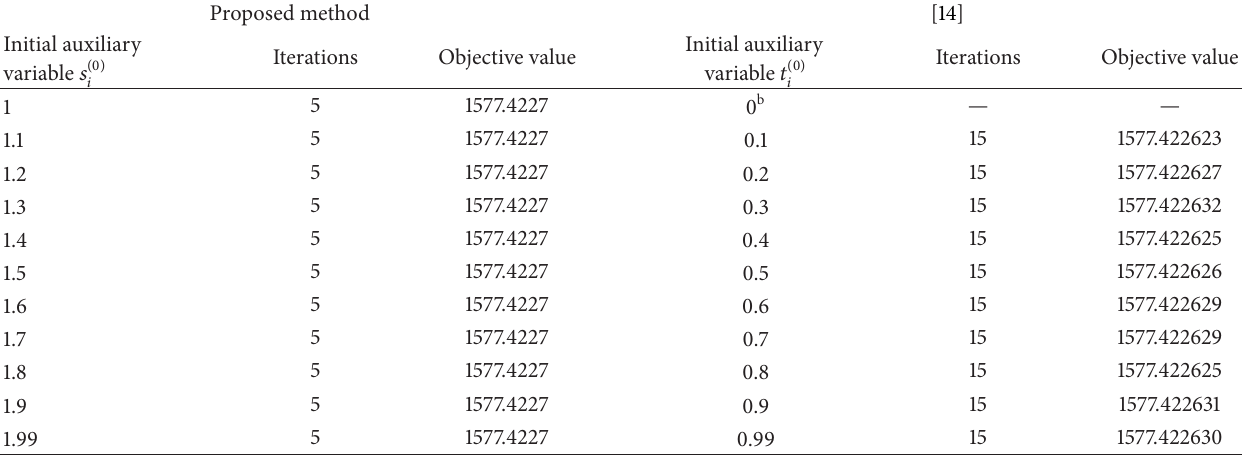
Table 4: Comparisons between the proposed algorithm and the method in [14] for Case study 2.